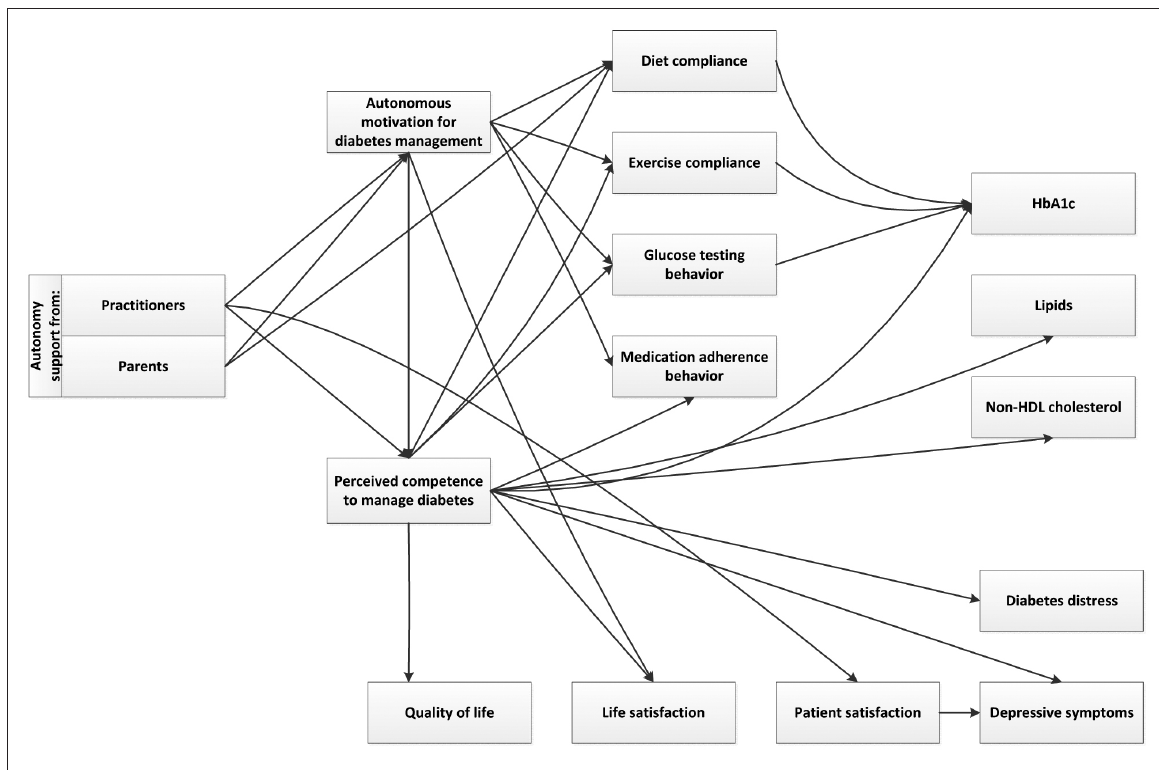
Figure. Model of the relationship between autonomy support and motivational process of health behavior in patients with diabetes from self-determination theory